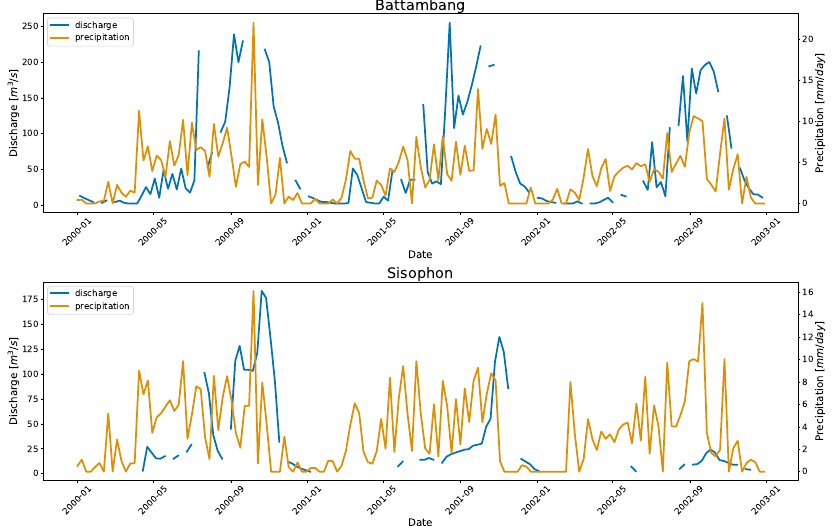
Figure A3. Plot of precipitation taken from CHIRPS [73] and the observed discharge. For visualization purposes, the data are downsampled into a weekly bin, and the mean values are shown. The left y-axis is for discharge (blue plot), and the right y-axis is for precipitation (orange